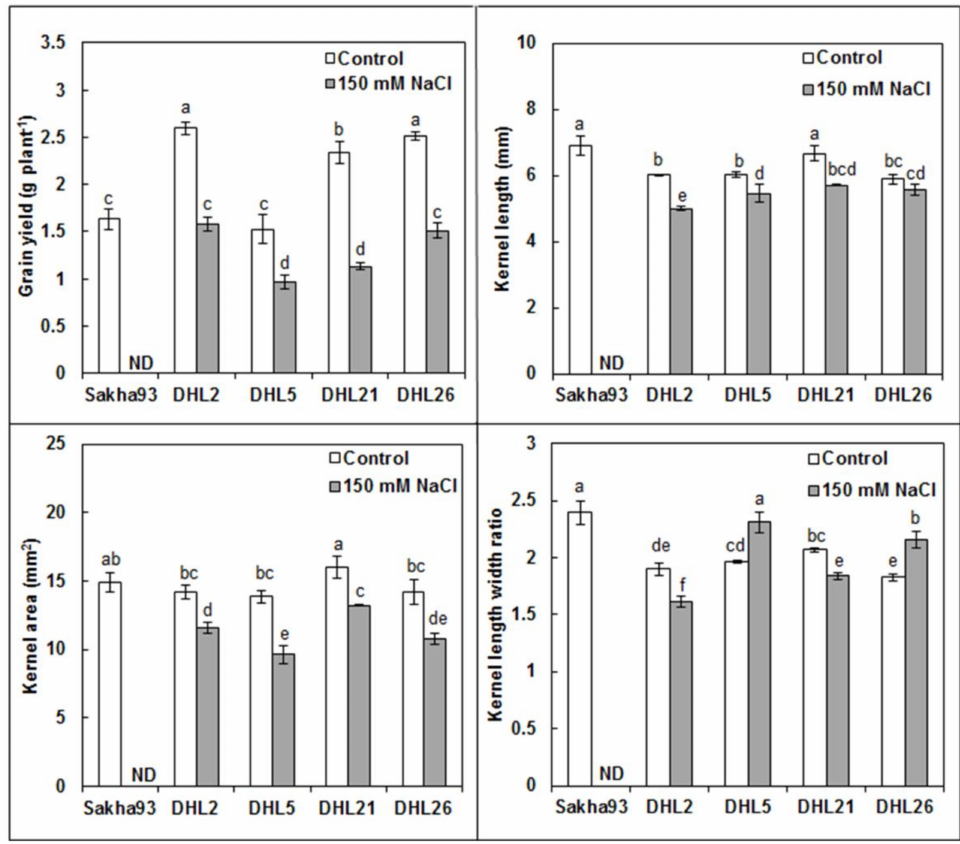
Figure 9. Impacts of salt stress on yield parameters of five wheat genotypes subjected to irrigation water with or without 150 mM NaCl. Values are presented as the mean ± SE of at least three replications, and values sharing the same letter for each treatment × genotype combination are not significantly different ( p ≤ 0.05) according to Duncan’s multiple range